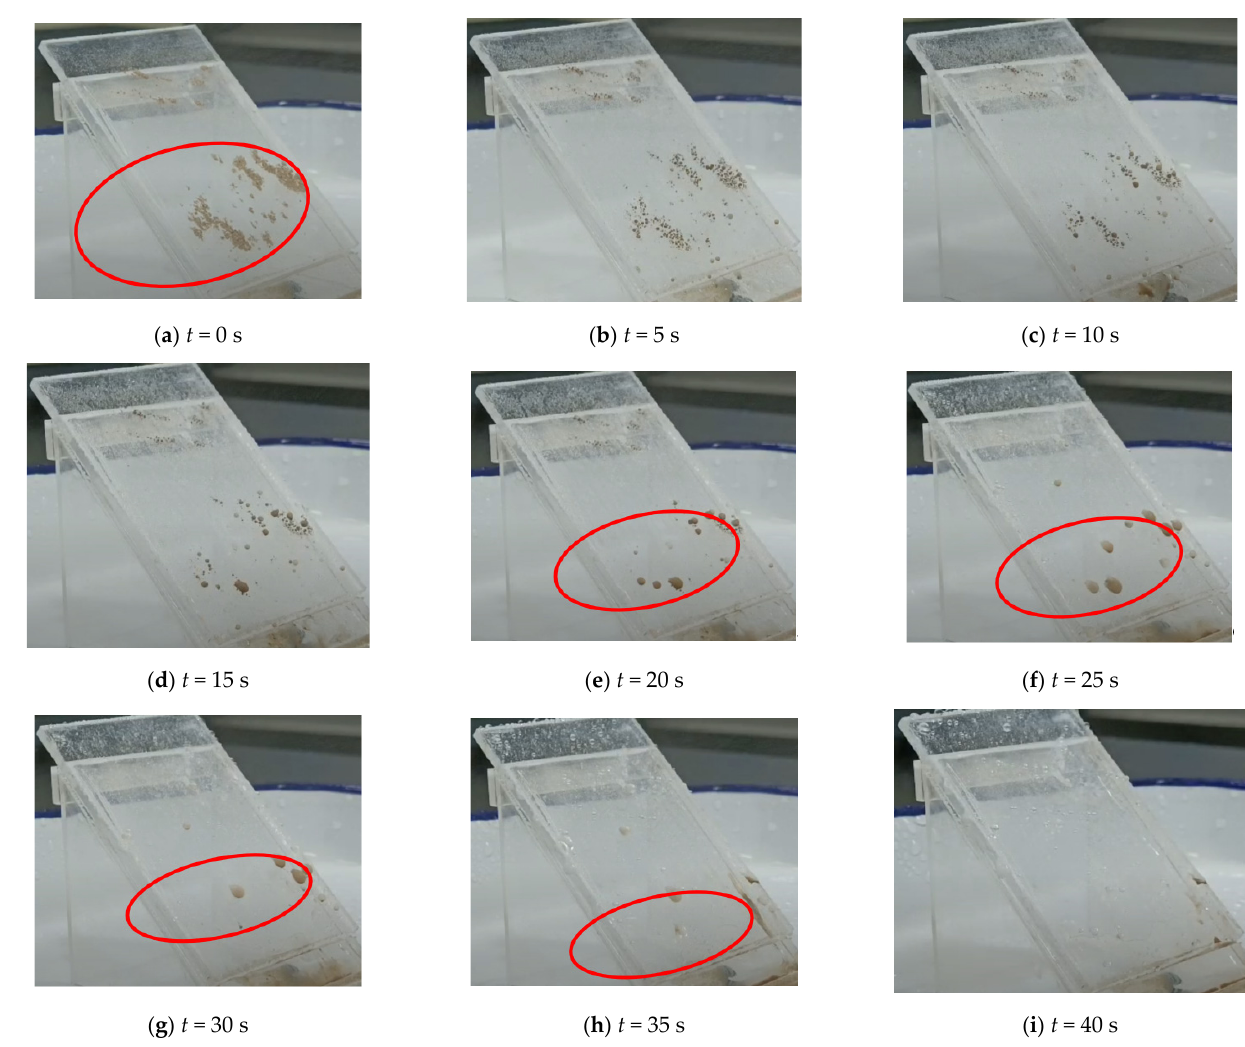
Figure 7. Dust cleaning process under water spraying for the super-hydrophobic coating. Figure 8. Dust cleaning process under water spraying for the super-hydrophobic